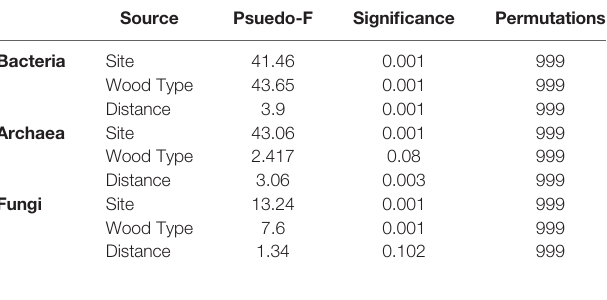
TABLE 1 | PERMANOVA conducted on results from the weighted UniFrac distance matrix to determine differences in microbiome community based on site, wood type, and distance from